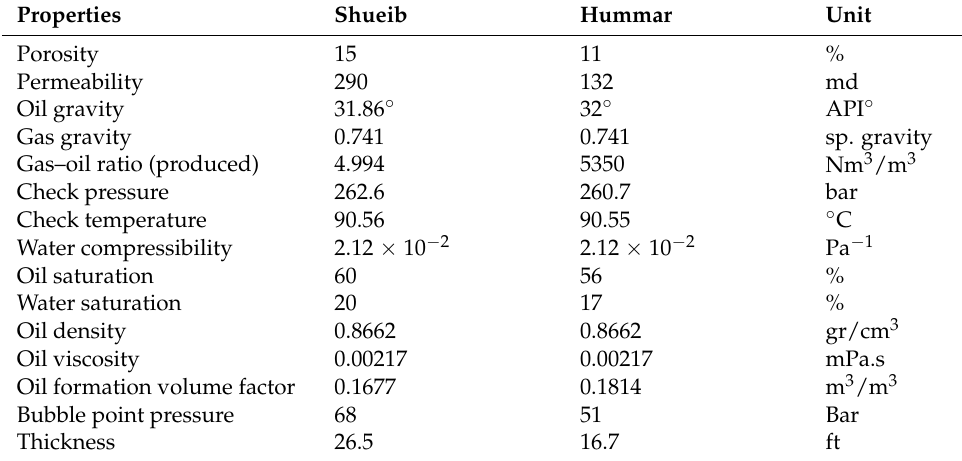
Table 1. Rock and fluid characteristics of